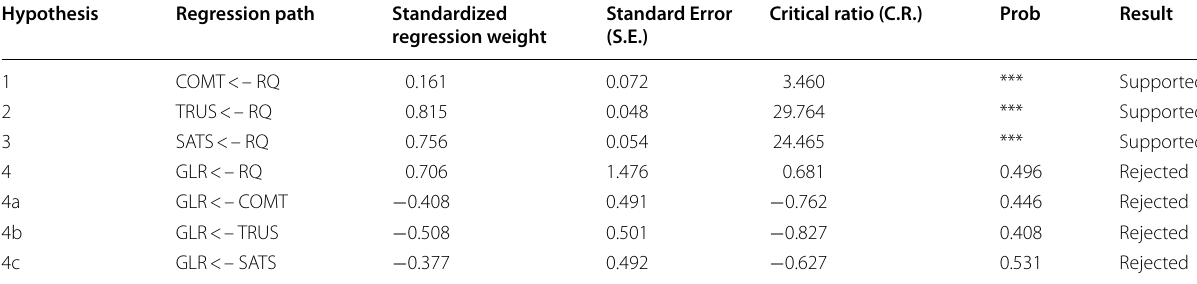
Table 5 Hypotheses testing